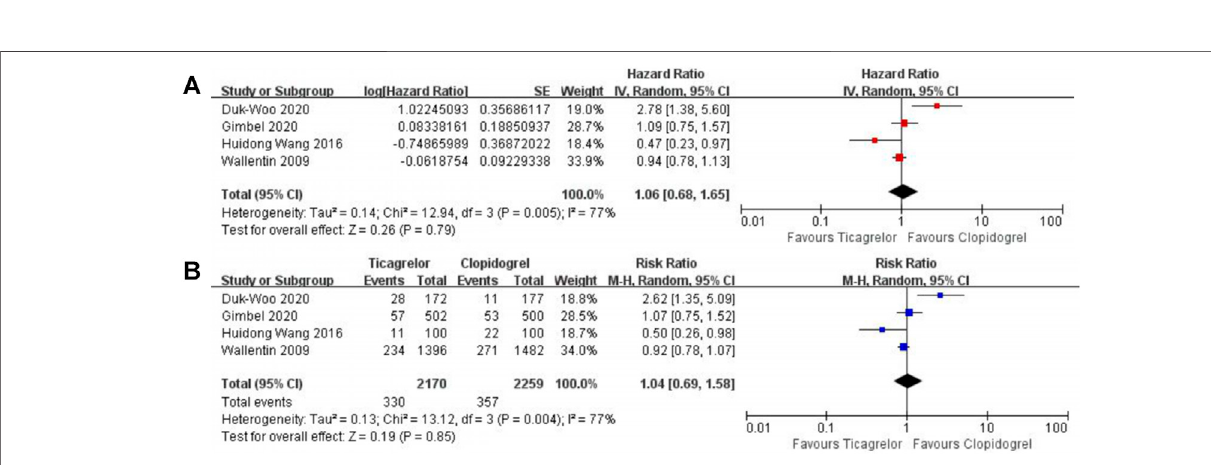
FIGURE4| Meta-analysiswithHR (A), RR (B) ,and 95%CIforthecomposite ofcardiovasculardeath, myocardial infarction,and stroke. Theboxes aretherelative riskestimatesfromeachstudy;thehorizontalbarsare95%CI.Thesizeoftheboxisproportionaltotheweightofthestudyinthemeta-analysis.HR,hazardratio;RR,risk ratio; CI, con fi dence interval.